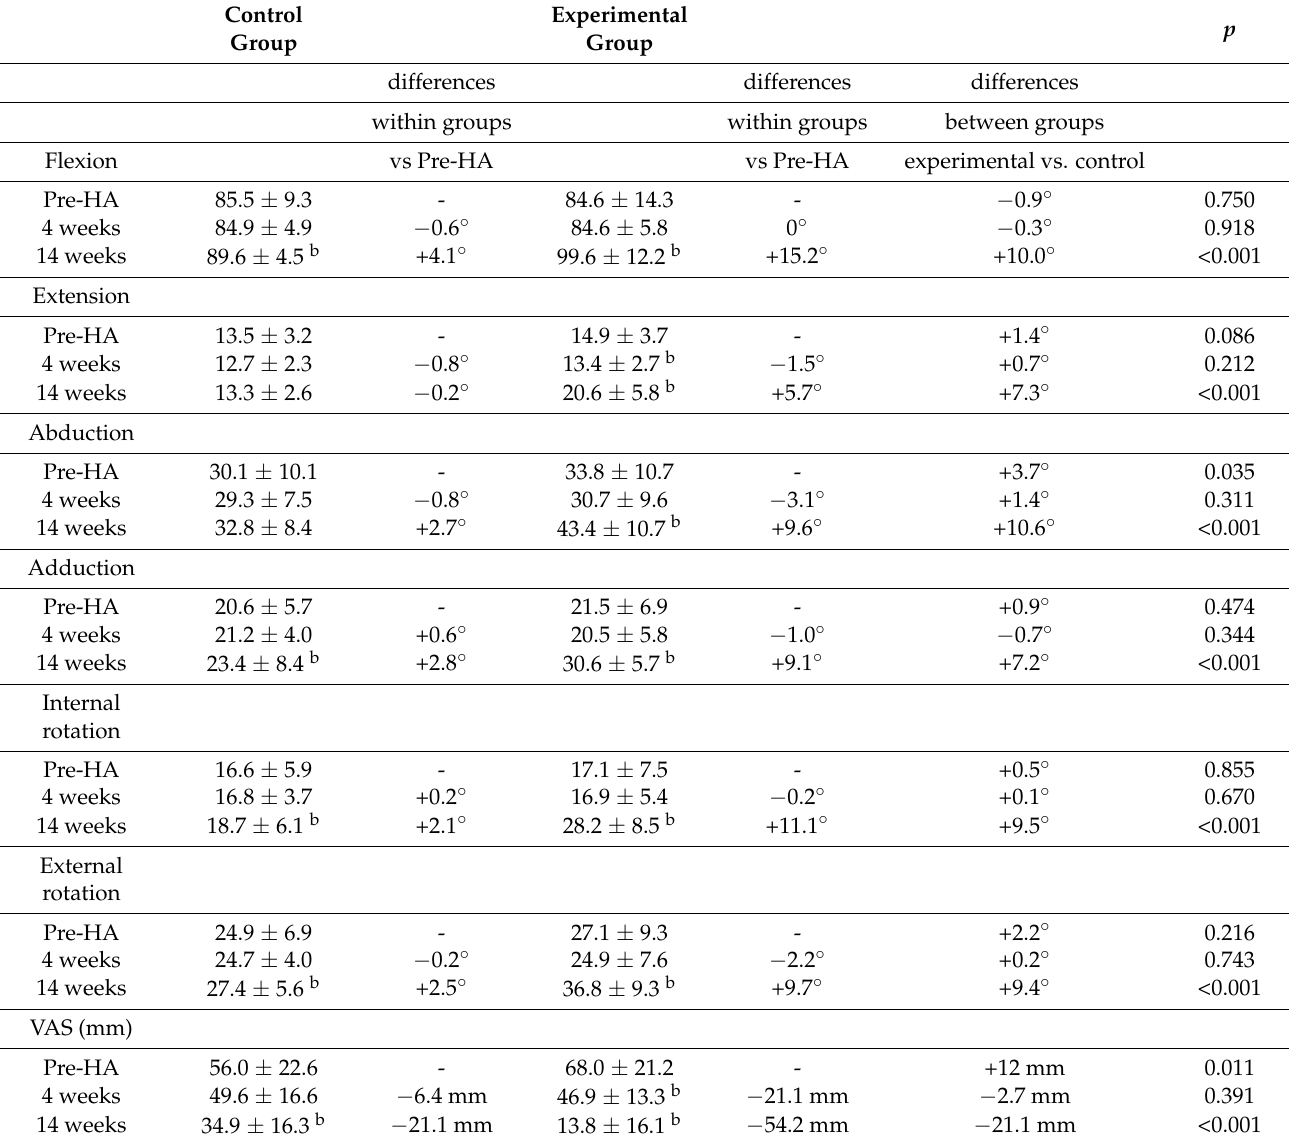
Table 3. Hip ROM and pain